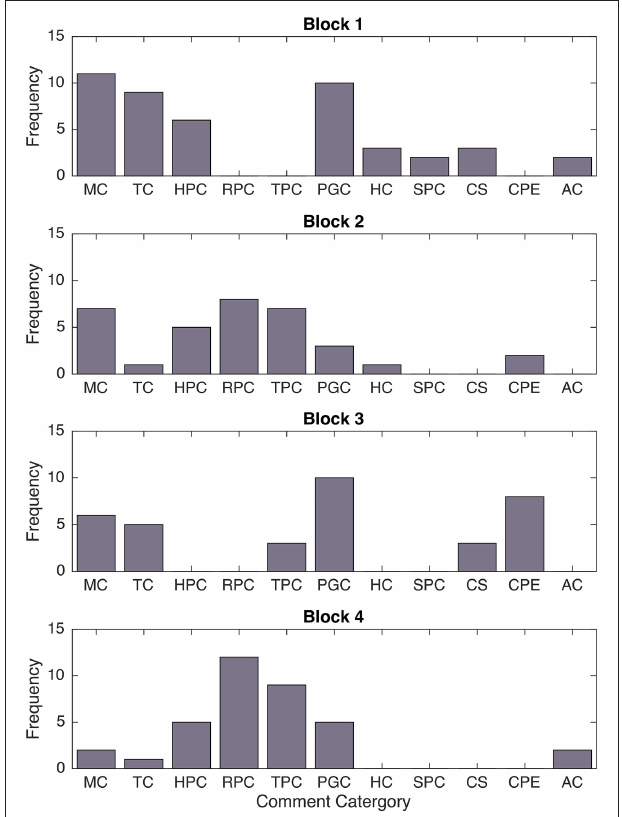
FIGURE 11 | Comparison of frequency of comments pertaining to various topics during different interaction blocks. The topic codes were: motion comments (MC), temporal comments (TC), human performance comments (HPC), robot performance comments (RPC), teamwork performance comments (TPC), positive general comments (PGC), haptic commentary (HC), social performance comments (SPC), cue suggestions (CS), comparisons to previous experience (CPE), and additional clarifications about how users were reading survey questions